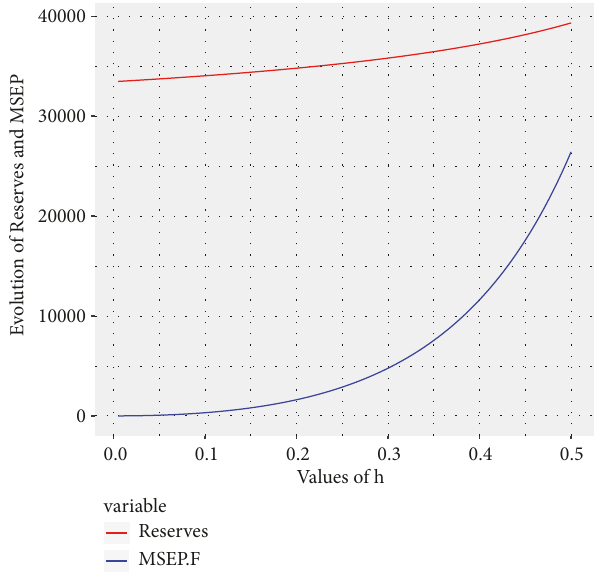
Figure 4: Evolution of reserves and MSEP with respect to ℎ− values (data of Table